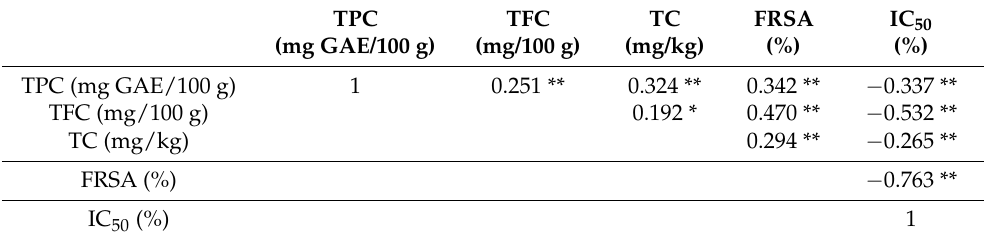
Table 4. Correlation coefficients among characters of biochemical properties of six Moroccan rapeseed varieties. TPC TFC TC FRSA IC 50 (mg GAE/100 g) (mg/100 g) (mg/kg) (%) (%) TPC (mg GAE/100 g) 1 0.251 ** 0.324 ** 0.342 ** − 0.337 ** TFC (mg/100 g) 0.192 * 0.470 ** − 0.532 ** TC (mg/kg) 0.294 ** − 0.265 ** FRSA (%) − 0.763 ** IC 50 (%) 1